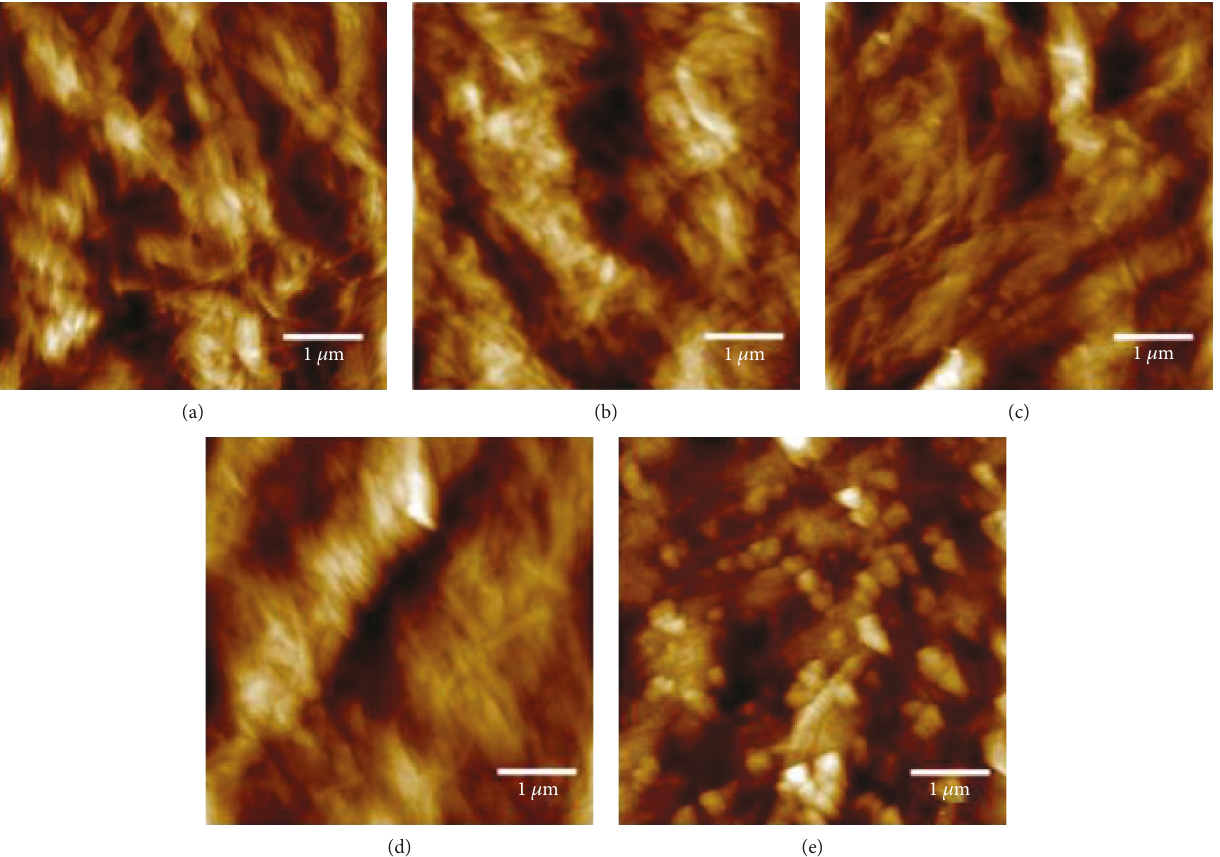
Figure 16: 5 × 5 μ m AFM topographies of bacterial nano fi bre paper: (a) on pristine sample; after adsorption of (b) polystyrene from toluene, (c) polystyrene from toluene/heptane, (d) poly(tri fl uoroethylene) from THF, and (e) poly(tri fl uoroethylene) from THF/toluene. Reproduced from reference [51] with permission from the American Chemical